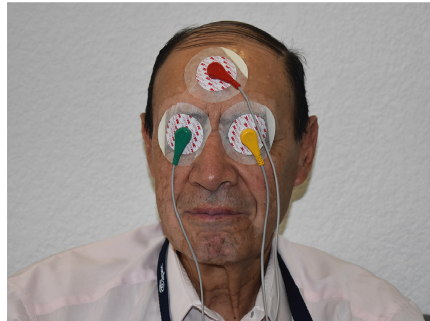
Figure 1: Transpalpebral electrical microstimulation procedure on a POAG